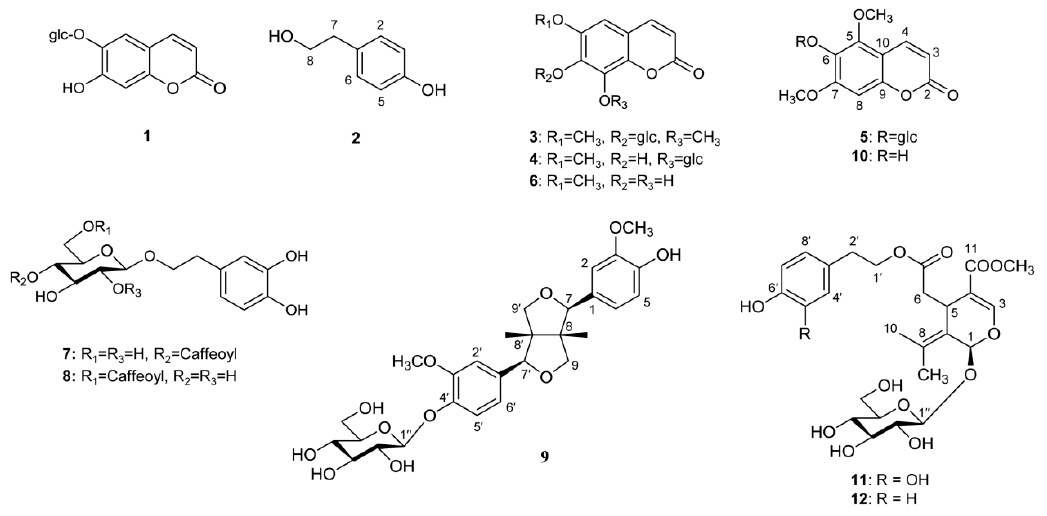
Figure 6. Chemical structures of peaks 1 – 12 . Table 5. Contents of twelve compounds ( 1 – 12 ) in the stem bark of Fraxinus